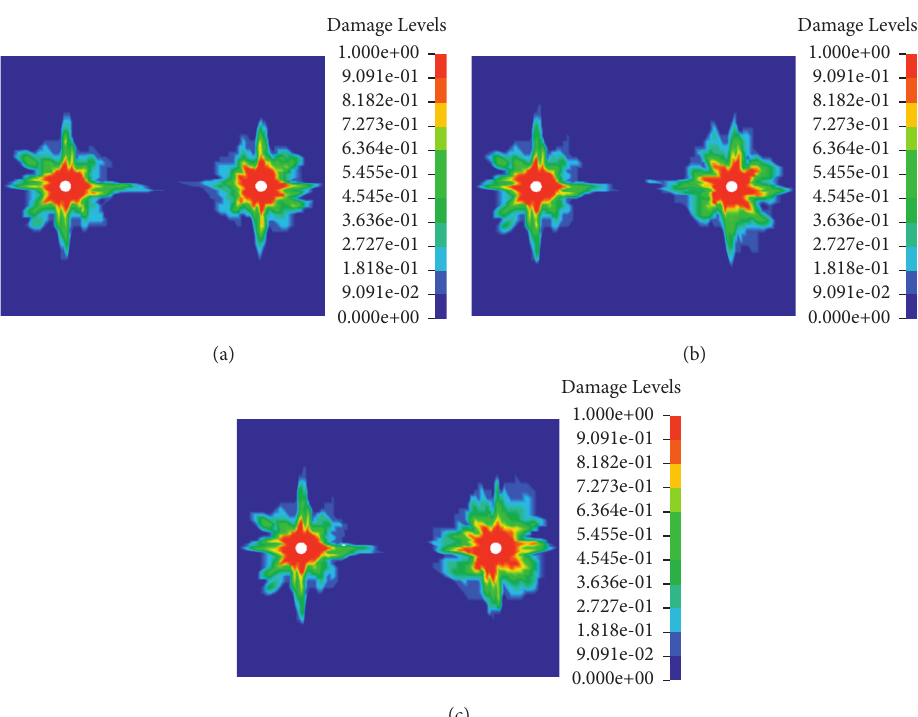
Figure 9: Near-zone damage nephogram of blasting models with different delay times. (a) Δ ( t ) � 0 ms. (b) Δ ( t ) � 5ms. (c) Δ ( t ) � 50ms.